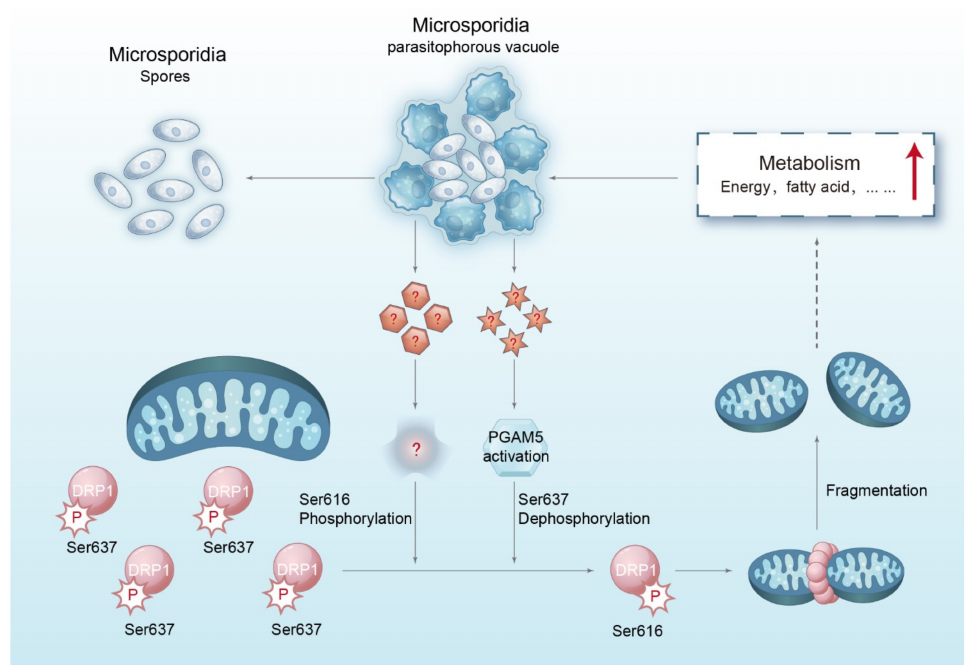
Figure 9. A model for microsporidia modulating HMF. Microsporidian infection promotes HMF